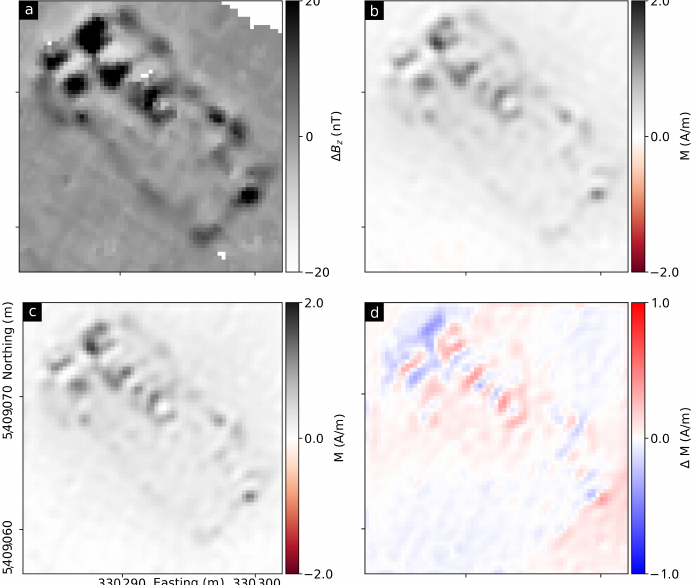
Figure 6. Comparison of magnetization distributions derived with least-squares inversion ( c ) and inverse filtering ( b ) on the example of a megastructure (magnetic map— a ) and difference between the two magnetization distributions ( d